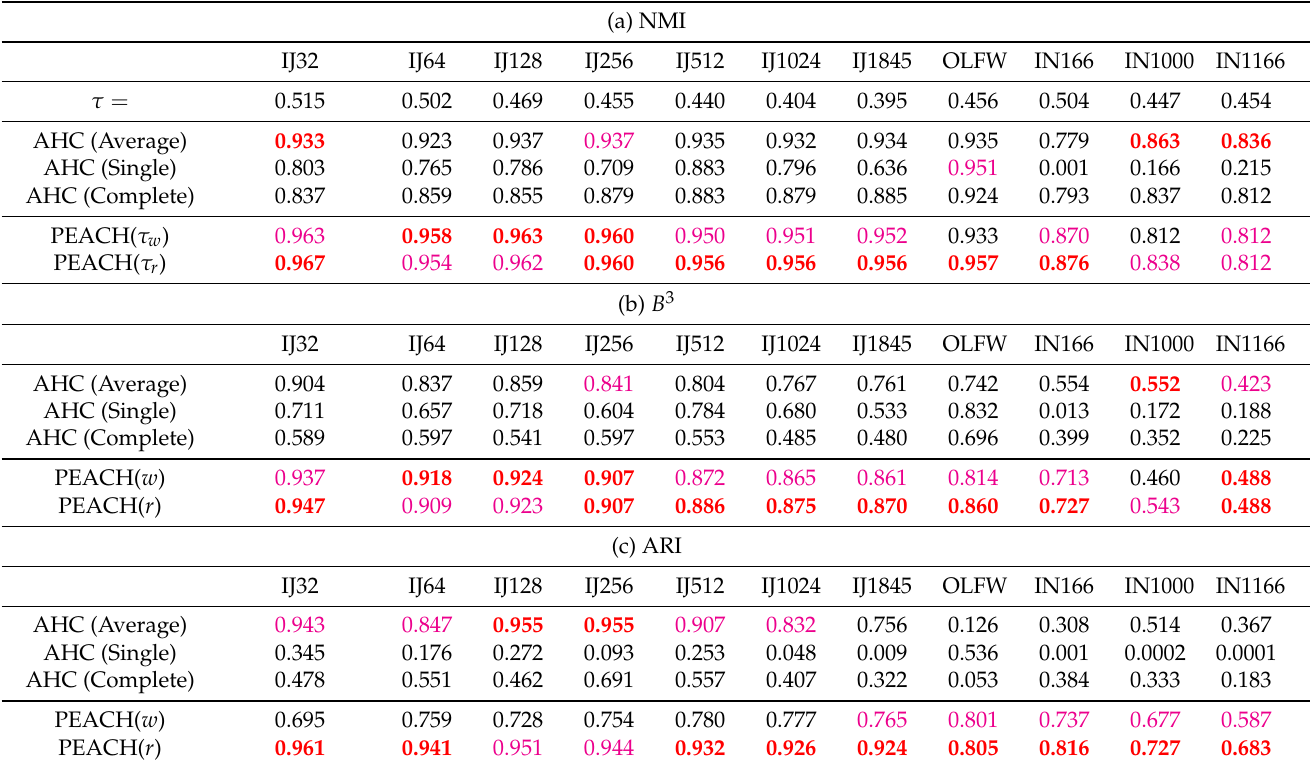
Table 7. AHC Linkages. These tables show NMI, B 3 , and ARI scores for AHC with classic linkages when using τ r to limit merges, while PEACH uses centroid linkage. Results are provided for all experiments. We mark the second-best and best results